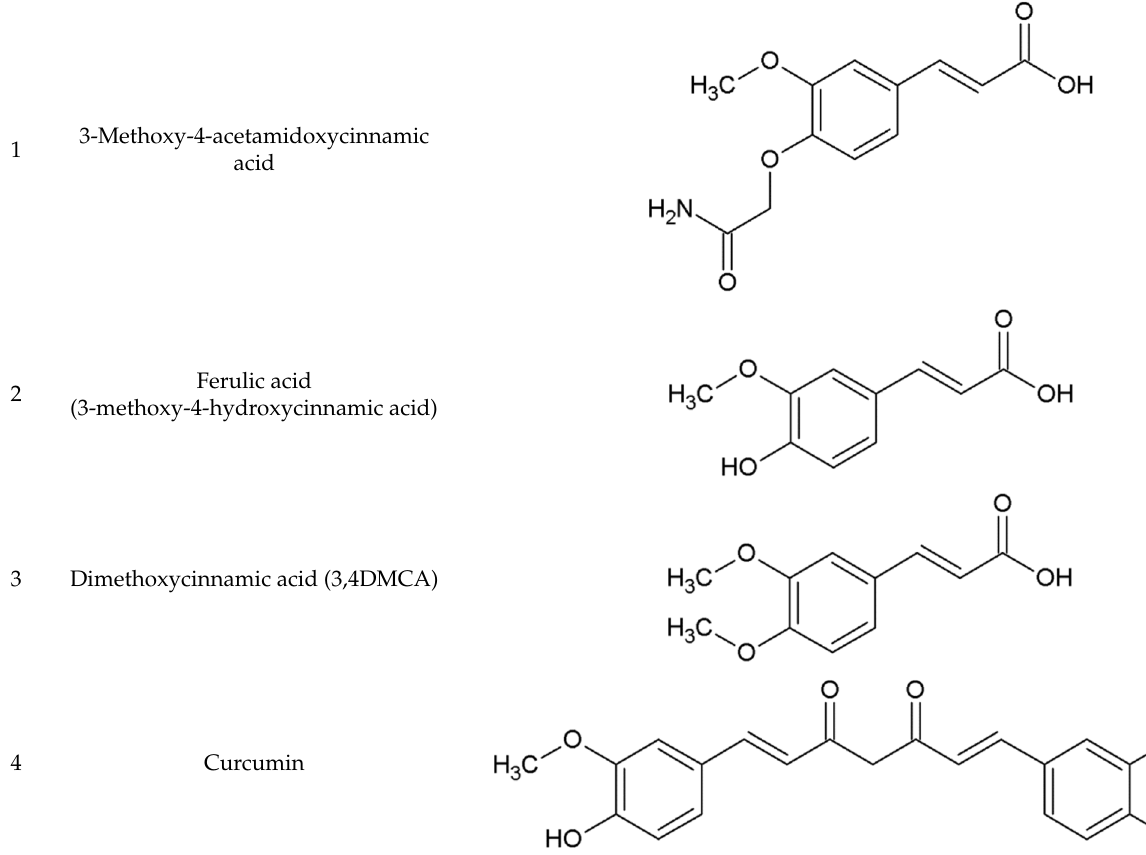
Table 2. 3,4DMCA derivatives and curcumin.